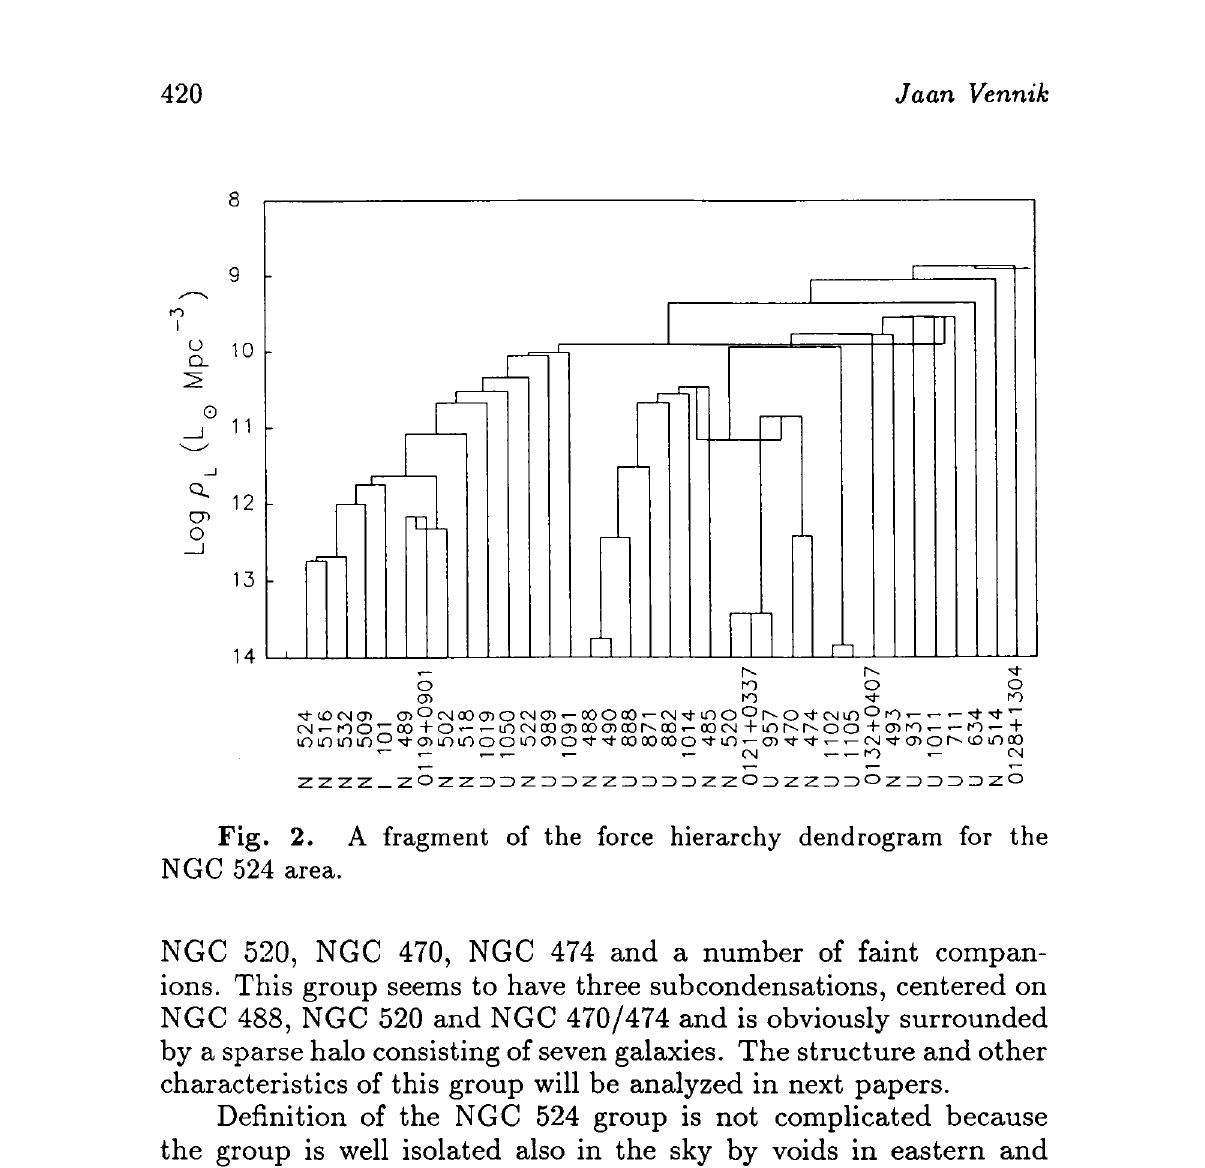
Fig. 2. A fragment of the force hierarchy dendrogram for the NGC 524